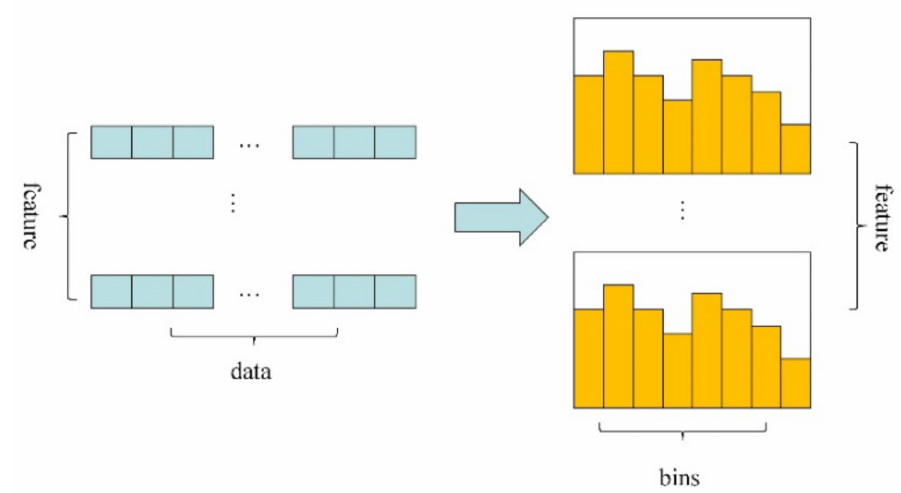
Figure 8. The diagram of the histogram-based algorithms in the search of split points.